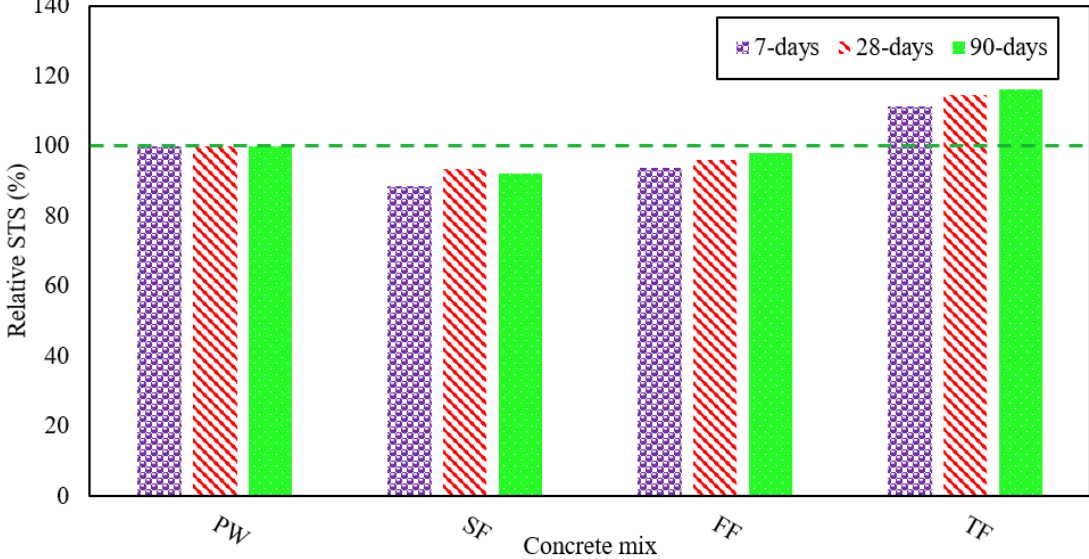
Figure 5. STS of various RAGC mixes relative to FW at 7, 28, and 90 days of testing.